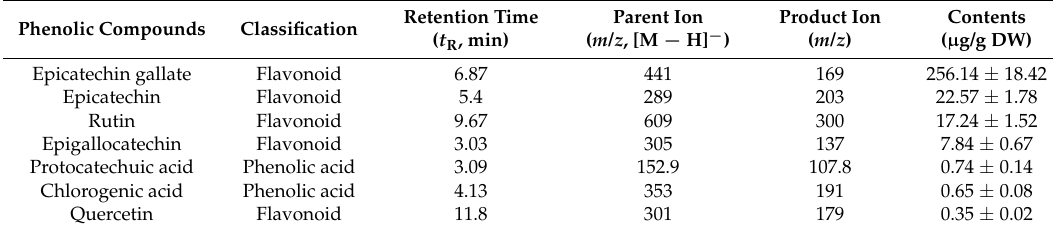
Table 4. The phenolic compounds in extract of M. sanguineum